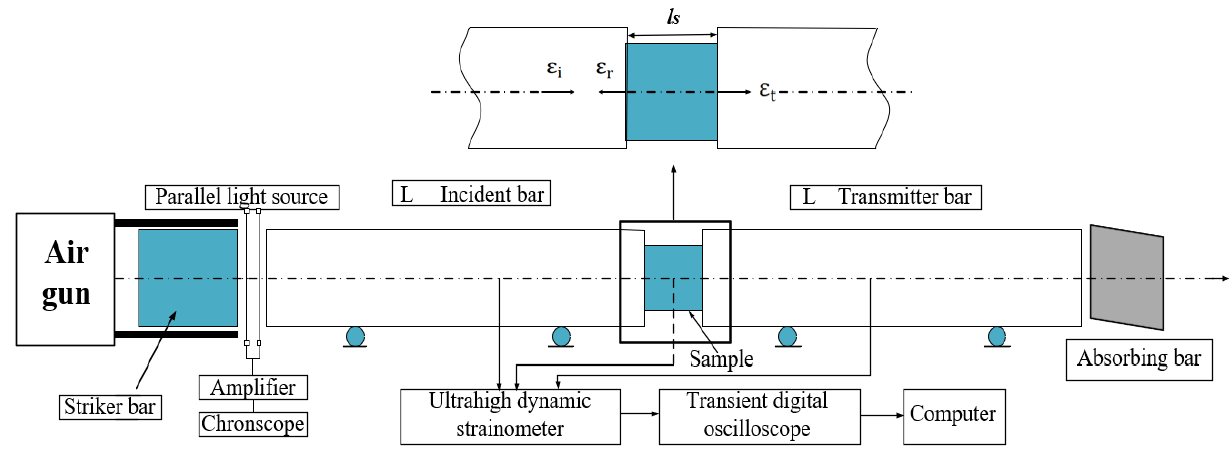
Figure 1. Schematic of a Split Hopkinson pressure bar apparatus.